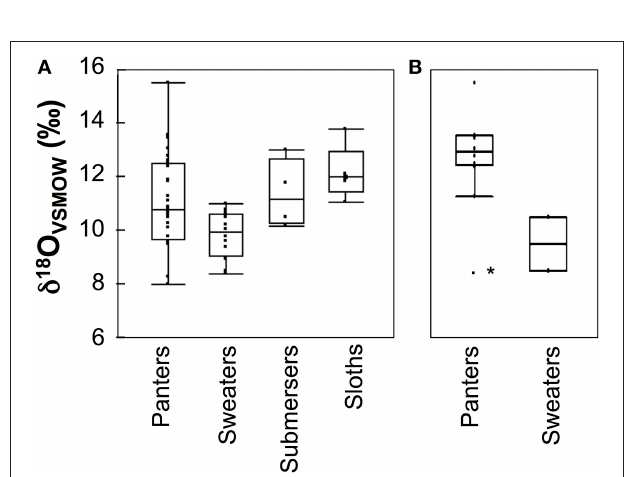
FIGURE 6 | Box plots comparing δ 18 O values among species that utilize different thermoregulatory mechanisms for (A) all sampled species, and (B) diurnal species at Sector Santa Rosa. For each group, boxes include median, 1st and 3rd quartiles, and whiskers extend 1.53 the interquartile range from the box. Submersers rely on submersion in mud or water to thermoregulate. Sloths are listed separately because they are able to change their internal body temperature (Britton and Atkinson, 1938). The asterisk denotes a coati with an outlier δ 18 O value. For a list of the primary thermoregulatory mechanism used by each species, see Table 1